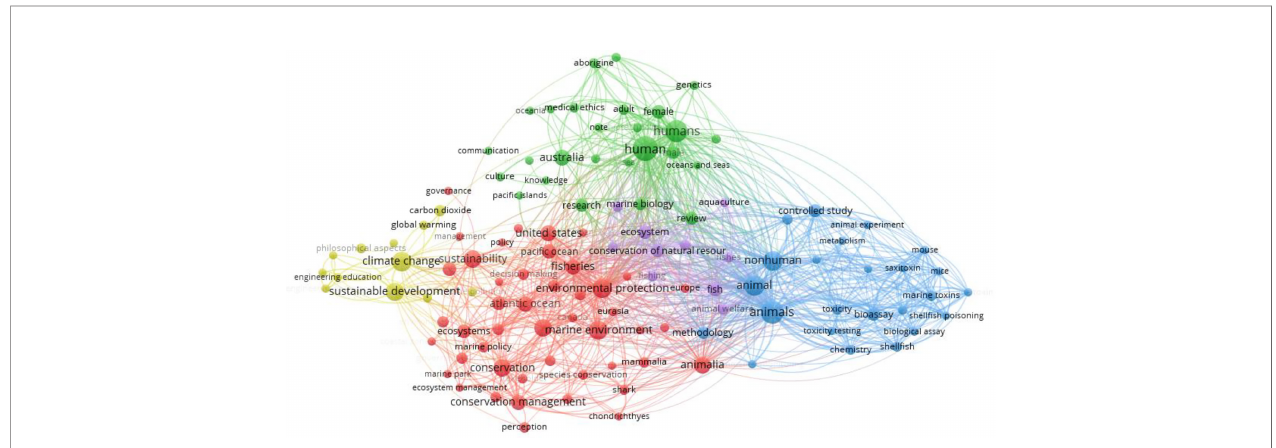
FIGURE 1 | Clusters (bubbles in same color) of keywords co-occurring at least 10 times in the 840 references identi fi ed for the topic ocean ethics, together with the links among them (lines in same